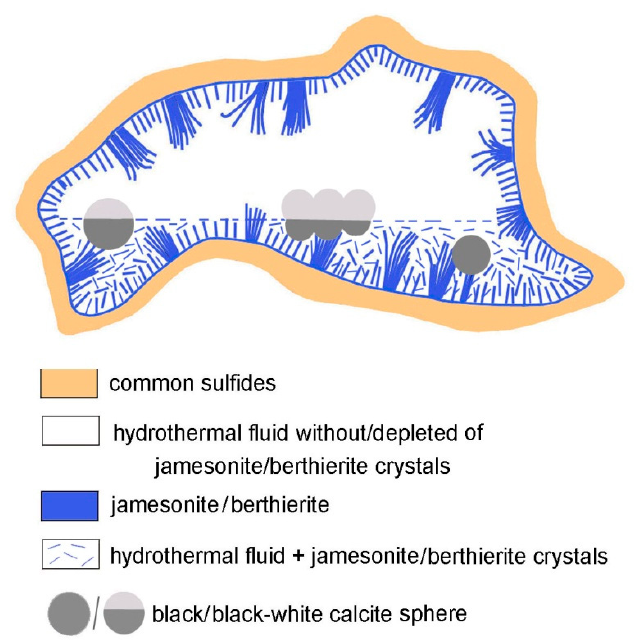
Figure 15. Schematic representation (not to scale) of a geode during late and final stage hydrothermal deposition from the Herja ore deposit where black and bicolor white and black calcite spheres formed. The walls of the geode are covered by late common sulfides sequence (sphalerite, galena, and chalcopyrite) followed by jamesonite / berthierite continuous sequence, needle-like crystals and fibroradial crystal groups. Loose sulfosalt crystals gravitationally concentrated at the bottom of the geode due to steady state hydrothermal fluid flow. Calcite spheres formed at the interface between the fluid layers with and without sulfosalt impurities would be bicolor, white in the upper part and black in the lower part, while those formed within the lower fluid layers would be black. Apparently loose calcite spheres were in fact temporary supported by dense jamesonite fibers network and / or fibroradial crystal groups.